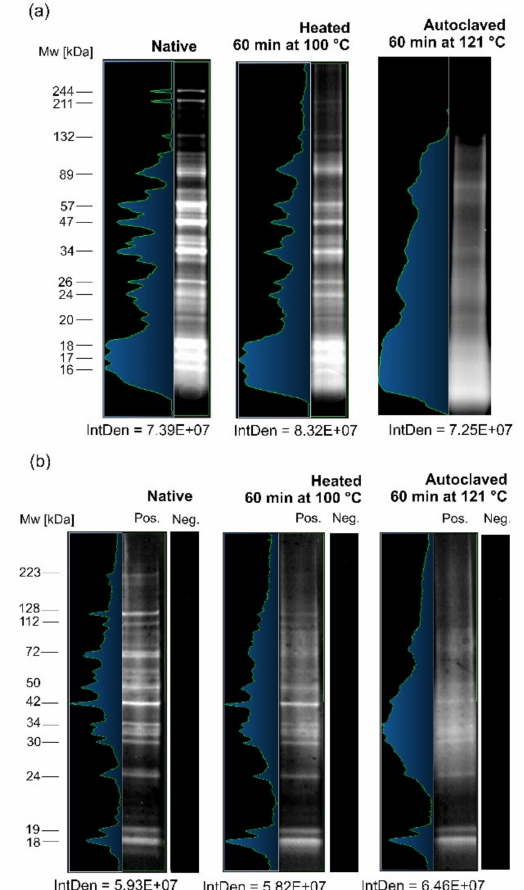
Figure 1. Colloidal Coomassie-stained SDS-PAGE analysis (color inversion mode) of the three following crude (CR) antigens of A. simplex : native, heated for 60 min at 100 ◦ C, and autoclaved for 60 min at 121 ◦ C ( a ). Western blot analysis of anti- A. simplex rabbit IgG antibodies reactivity against following CR antigens of A. simplex : native, heated 60 min at 100 ◦ C, and autoclaved for 60 min at 121 ◦ C ( b ). Pos.—membrane incubated with hyperimmune serum from a rabbit immunized with A.